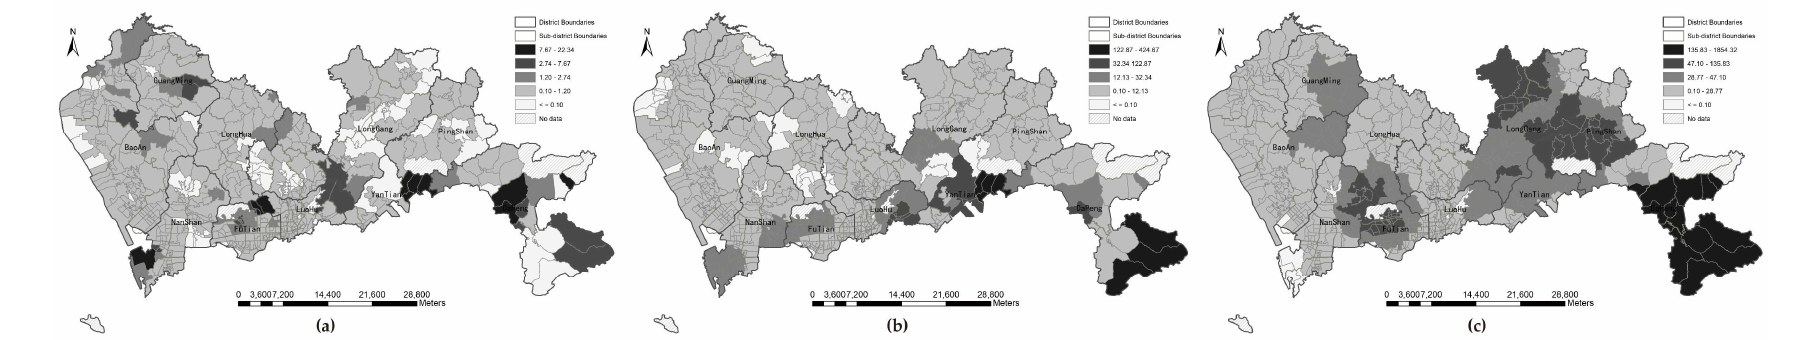
Figure 6. Park accessibility by Euclidean distance at three levels: ( a ) community park level; ( b ) city park level; ( c ) natural park level.